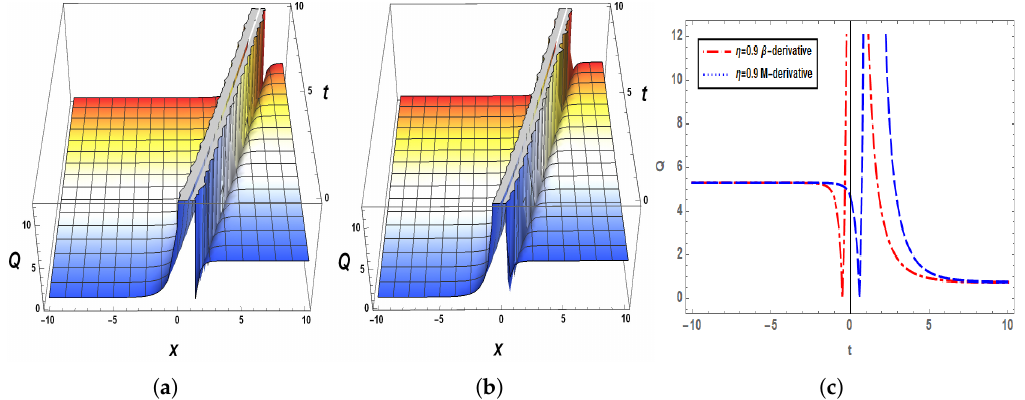
Figure 9. Graphical representation of Q 8,2 ( x , t ) letting µ = 0.5, γ = − 0.8, σ = 0, θ = 1, ϑ = 1, (cid:101) = 0.5, λ = 1, and C = − 1. Here, ( a – c ) show 3 D , as well as the 2 D surface graphs for η = 0.9.